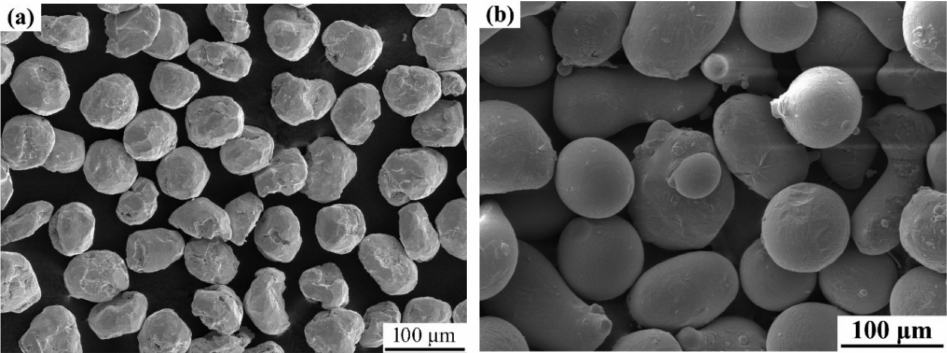
Figure 1. Morphology of ( a ) Mo and ( b ) 316L stainless-steel sprayed